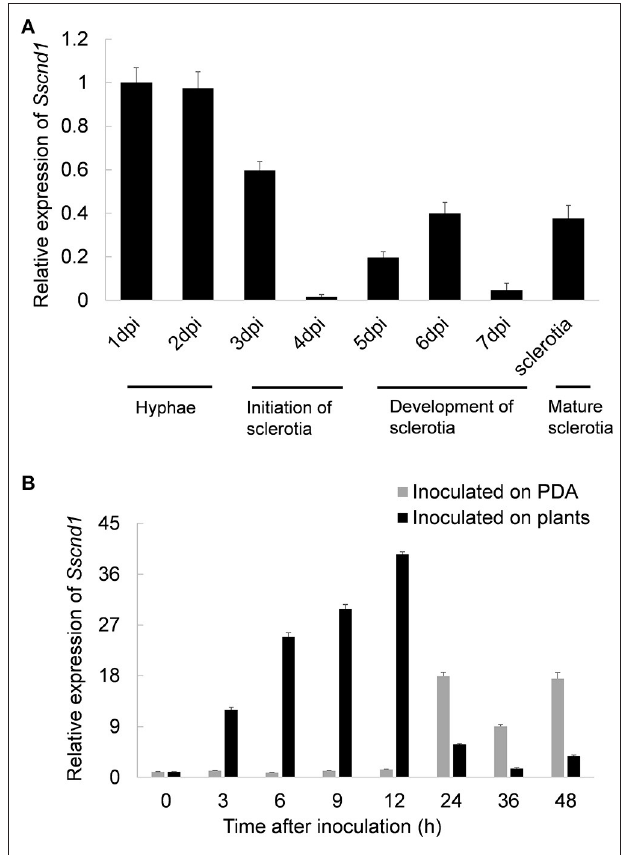
FIGURE 2 | Expression analysis of Sscnd1 during various stages. (A) Quantitative real-time reverse transcription-polymerase chain reaction (qRT-PCR) analysis of the Sscnd1 gene expression during different developmental stages of sclerotia. (B) Expression analysis of Sscnd1 in S. sclerotiorum after contact with rapeseed leaves and growing on potato dextrose agar (PDA) plates. The quantity of Sstub1 was used to normalize the expression levels of Sscnd1 in different samples. The relative abundance of Sscnd1 cDNA in the hyphae on PDA at 1 dpi (A) and in the hyphae inoculated on plants at 0h (B) was set as one, respectively. Error bars indicate the standard deviation of three independent assays.